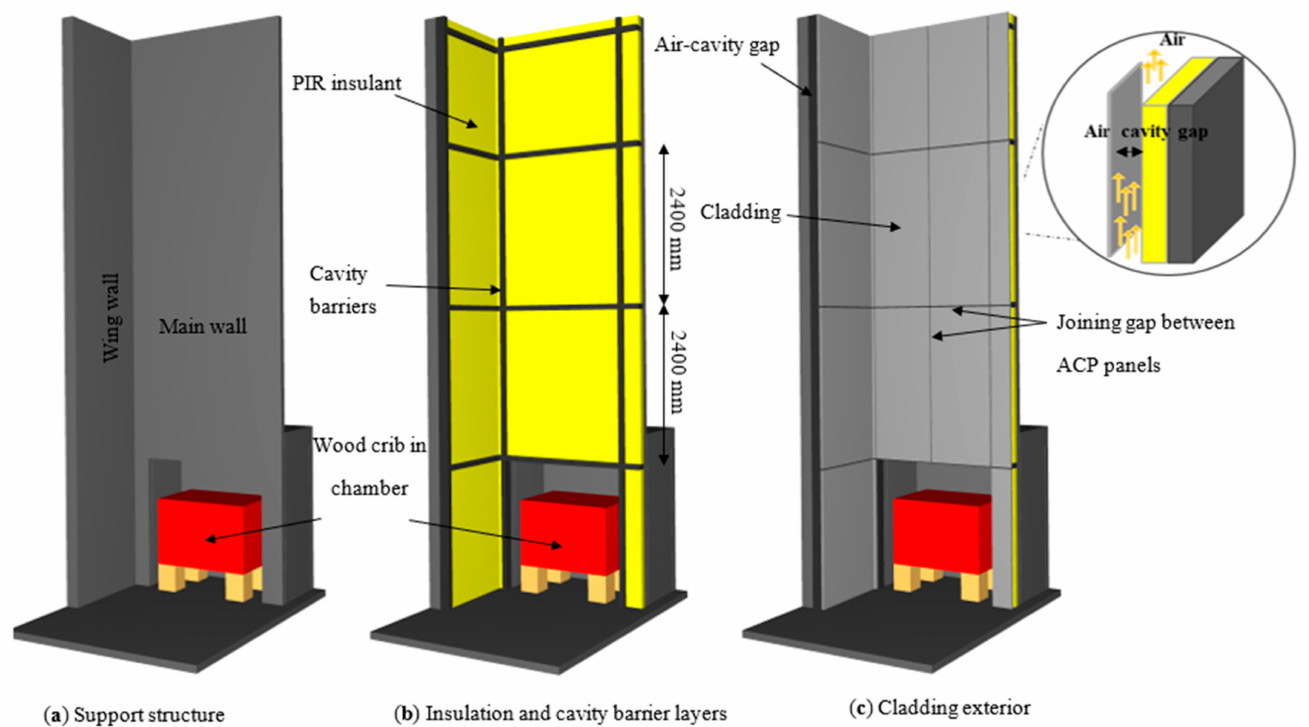
Figure 2. Configuration details of FDS model developed in accordance with BS 8414-1 standard.